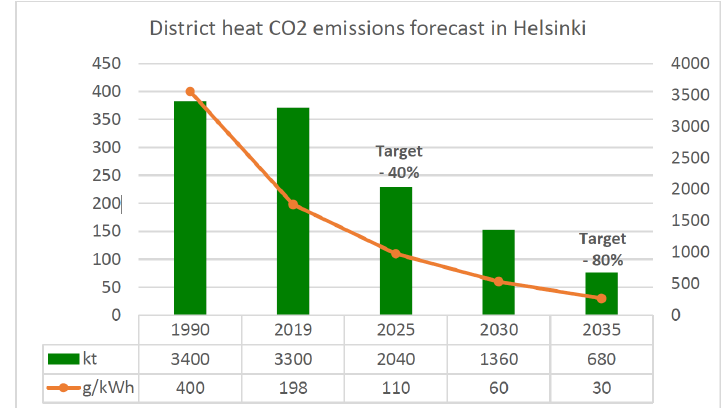
Figure 6. Expected development of the Helen district heating network CO 2 emissions